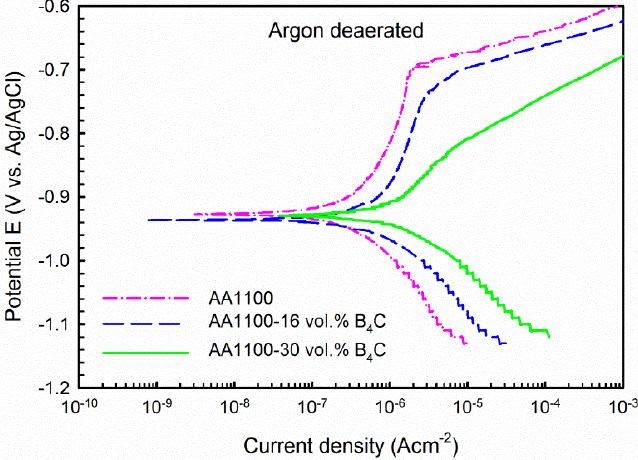
Figure 7. Potentiodynamic polarization curve recorded on AA1100, AA1100-16 vol.% B 4 C and AA1100-30 vol.% B 4 C in 3.5 wt.% NaCl in argon deaerated condition.